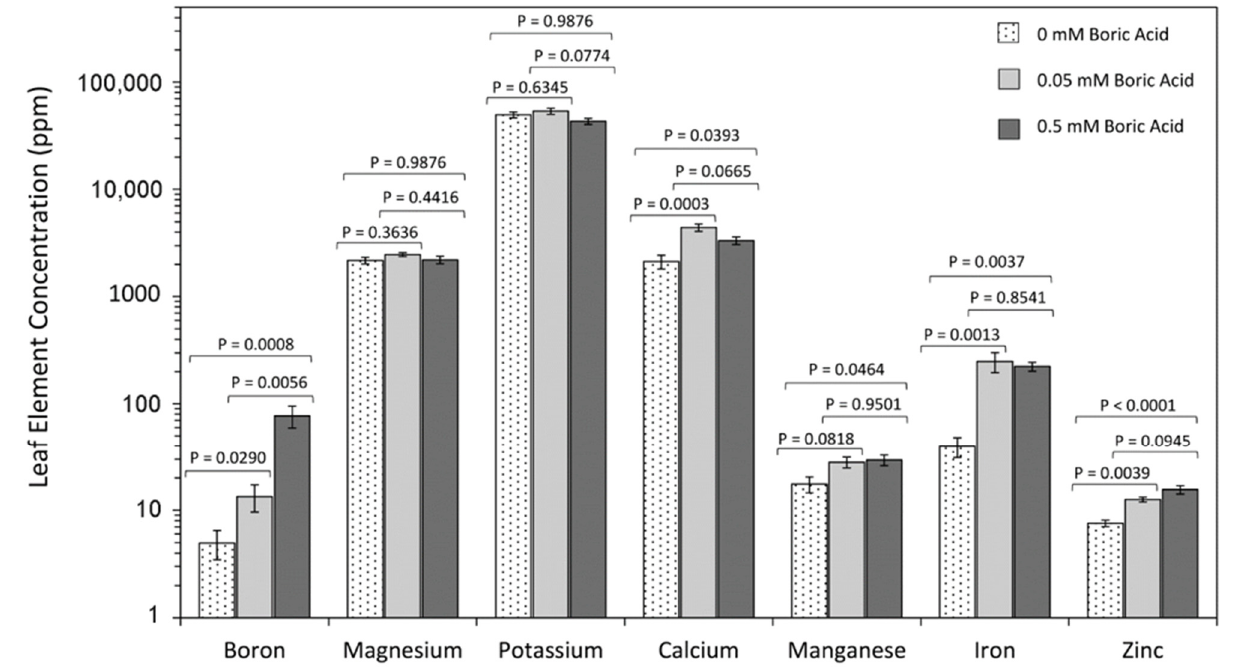
Figure 7. ICP-MS analysis of leaf tissues for elements, including boron, magnesium, potassium, calcium, manganese, iron, and zinc. Data bars reflect average values in ppm concentrations in dried tissue mass ± SE on N = 6 replicates. Levels of significance are represented by p values calculated using one-way analysis of variance with a post hoc Tukey’s HSD test to account for multiple comparisons between the different treatment groups (0 mM-to-0.05 mM BA; 0.5 mM-to-0.05 mM BA; and 0 mM-to-0.5 mM BA). Statistical significance was set at p < 0.05. As expected, other elements also showed changes across the range of BA